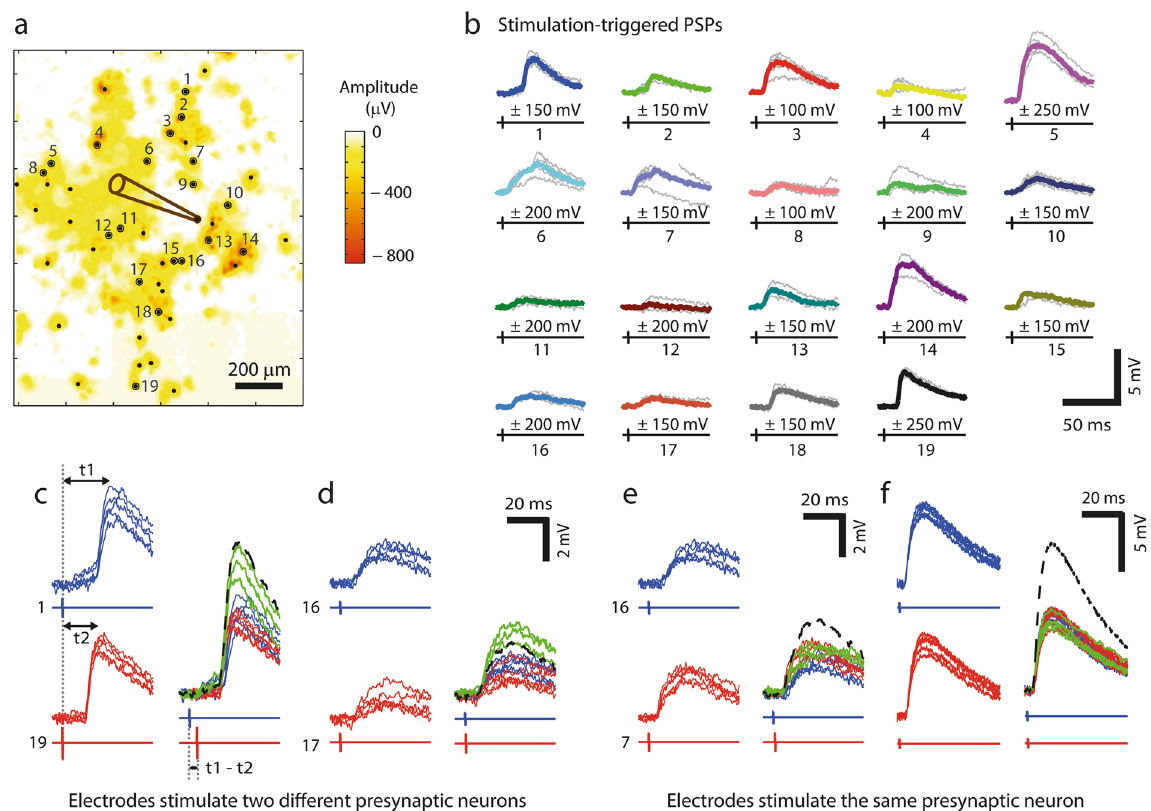
Figure 7. Stimulation-triggered PSPs from multiple presynaptic inputs. ( a ) SSAM of a MEA region with the color code indicating negative peak amplitudes of the spikes at each electrode. The position of the patched cell is indicated by the pipette drawing. Electrode locations (depicted as black dots) were selected according to large negative peaks in the recorded signal amplitude map and then used for stimulation with bipolar voltage pulses of 100, 150, 200 and 250 mV amplitude. Small dots mark electrodes that either did not evoke any PSP response or could not be associated with individual monosynaptic PSPs; large dots mark electrodes through which the stimulation yielded individual PSPs. ( b ) PSP responses (gray: individual traces; median traces are colored) for stimulation through the numbered electrodes in ( a ), where the lowest PSP-evoking stimulation voltage was chosen for every electrode. The stimulus timing are visualized by the black signals below the PSPs. ( c ) Left : PSPs and stimulus for electrodes 1 and 19 (from b ), which exhibited similar amplitudes but different latencies (t1, t2: time between stimulation pulse and PSP maximum). Right : Paired stimulation for electrodes 1 and 19 , where the timing between the two stimuli was t1 – t2 = 3.65 ms. The green traces show responses to paired stimulation, and red respectively blue traces represent the PSP responses to the individual stimuli (as shown left ). The green responses to paired stimulation featured clearly larger amplitudes than the responses to individual stimuli, suggesting that the PSPs obtained through stimulation at electrodes 1 and 19 originated from two different presynaptic inputs. The black dashed line visualizes the theoretical sum of the individual average PSP responses. ( d ) Second example showing significantly larger responses to paired stimulation as compared to individual stimulation, thus indicating two different presynaptic sources. ( e ) Example, where paired stimulation does not produce larger PSP amplitudes than individual stimuli, indicating that stimulation of electrodes 16 and 7 activated the same presynaptic neuron. Note the comparably large spatial distance between the two electrodes in ( a ). ( f ) Example from another dataset, where PSP responses upon stimulation through two different electrodes were also evoked by the same presynaptic